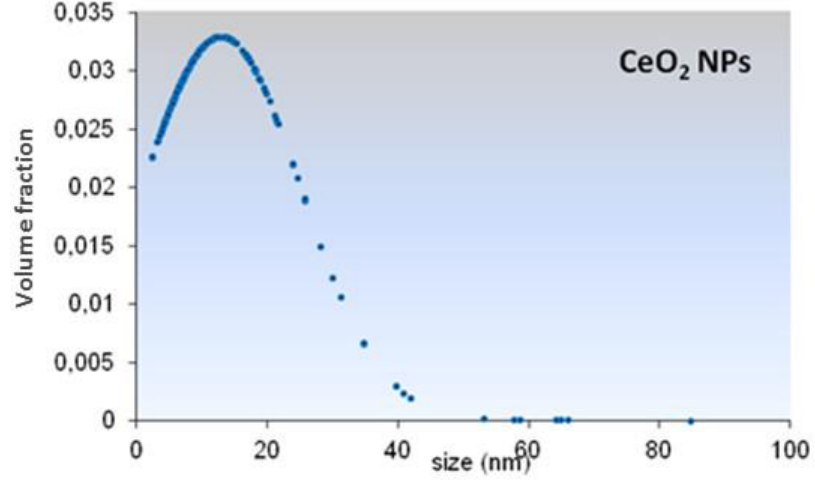
Figure 2. Size distribution of CeO 2 -NPs.